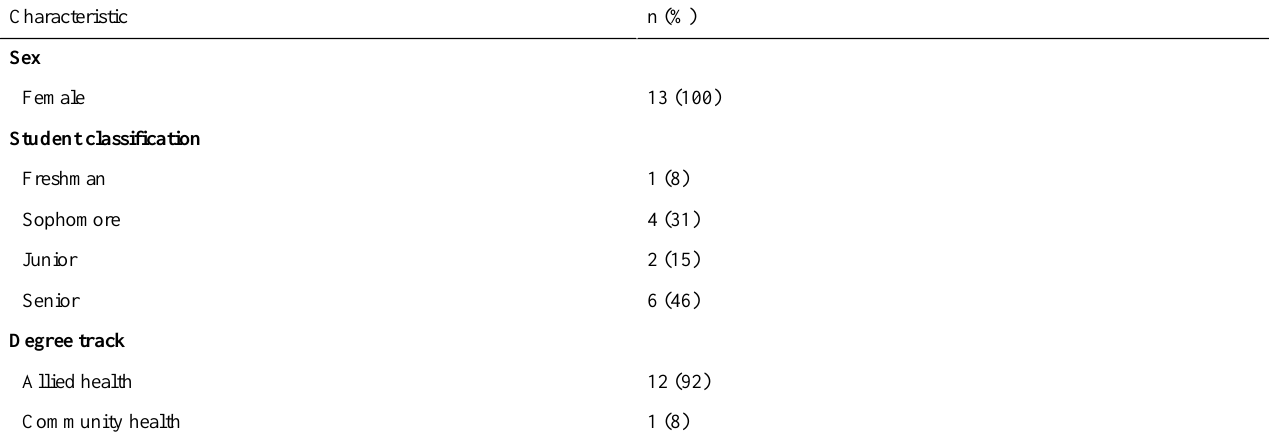
Table 2. Demographic characteristics of